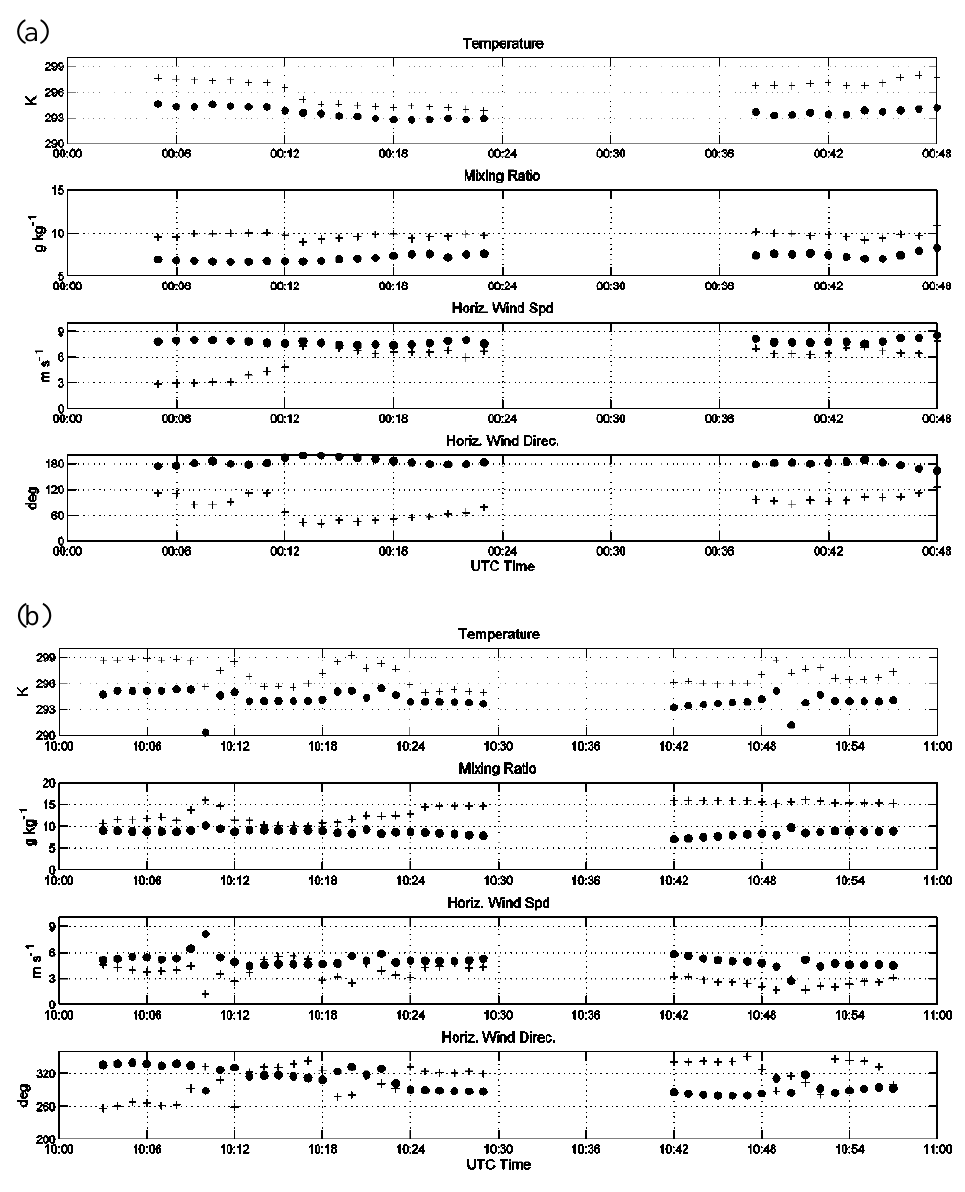
Fig. 5. Model verification versus time using Twin Otter Flight #12 (3–4 July 2007, (a) ) and Flight #13 (6–7 July 2007, (b) ) measurements intercepting the third model grid. Variables depicted include: temperature, water vapor mixing ratio, scalar-average horizontal wind speed and direction. Model estimates are interpolated to observations and both are organized into 1min bins. Each row shows the (bin-averaged) observed values (+) and model estimates